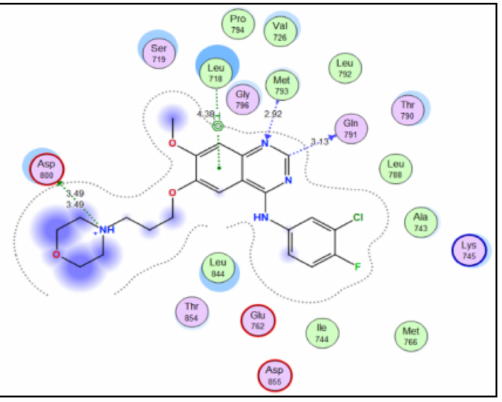
Figure 7. Two-dimensional interaction diagram showing cocrystallized (gefitinib) docking pose interactions with key amino acids in the EGFR binding site.